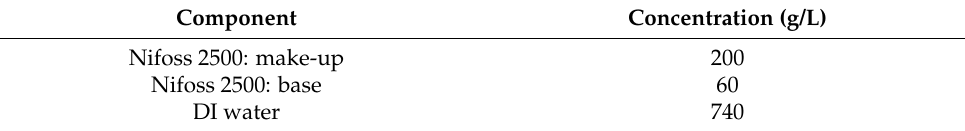
Table 3. Electroless bath content used for the deposition process.